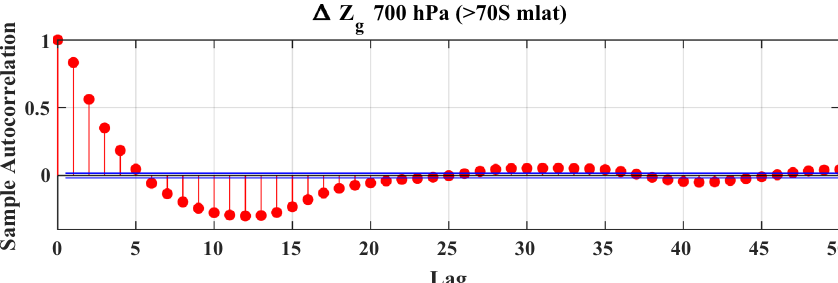
Fig. 1. Temporal autocorrelation of D Z g over the period 1980 – 2016. Positive auto-correlation occurs until day 5. The blue lines show the 95% con fi dence bounds of the autocorrelation function.